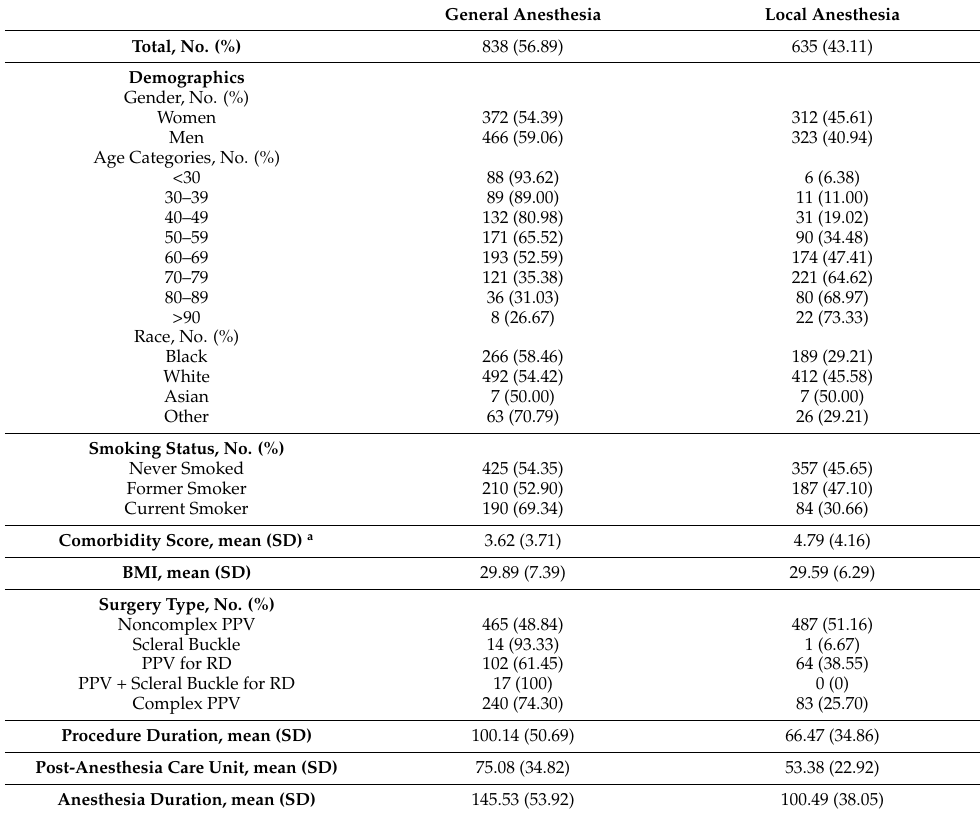
Table 1. Demographic Characteristic, Procedural Duration, Anesthesia Duration, and PACU Duration Between General Anesthesia and Non-General Anesthesia Groups Undergoing Vitreoretinal Surgery.